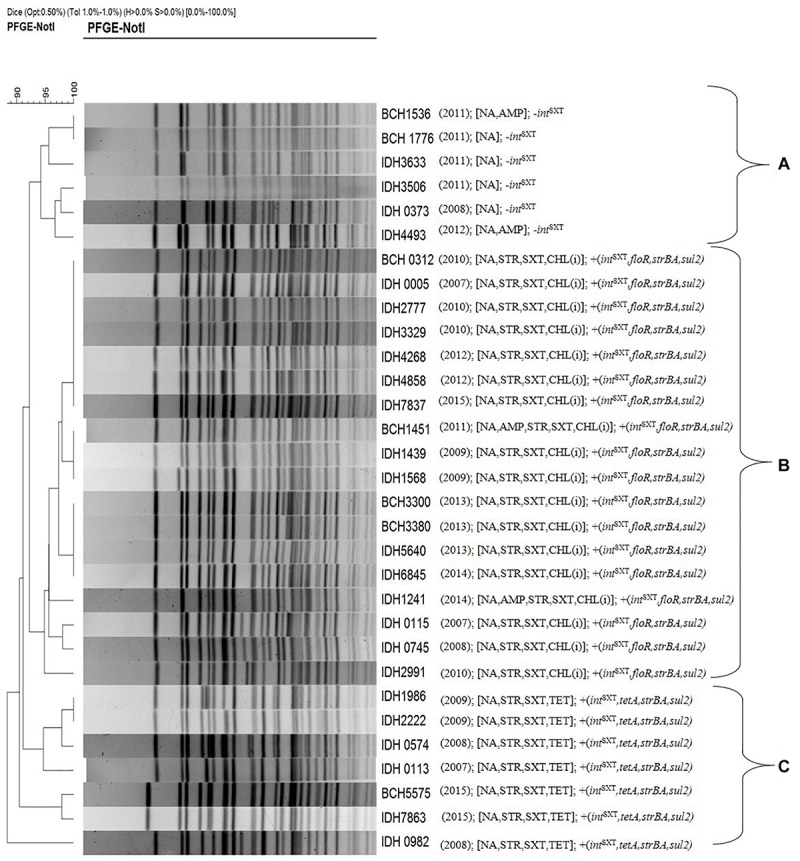
PFGE profile of the representative V. cholerae O1 strains with their antimicrobial resistance. Cluster A, strains devoid of intSXT or ICE; Cluster B, strains carrying ICEGEN; Cluster C, strains having ICETET. Number in the parenthesis represents the year of isolation.